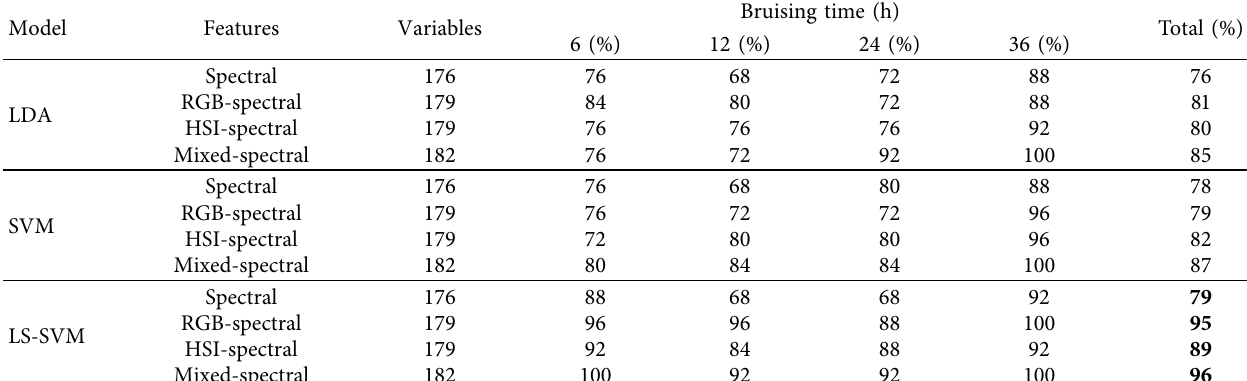
Table 1: Classification results of LDA, SVM, LS-SVM Model.